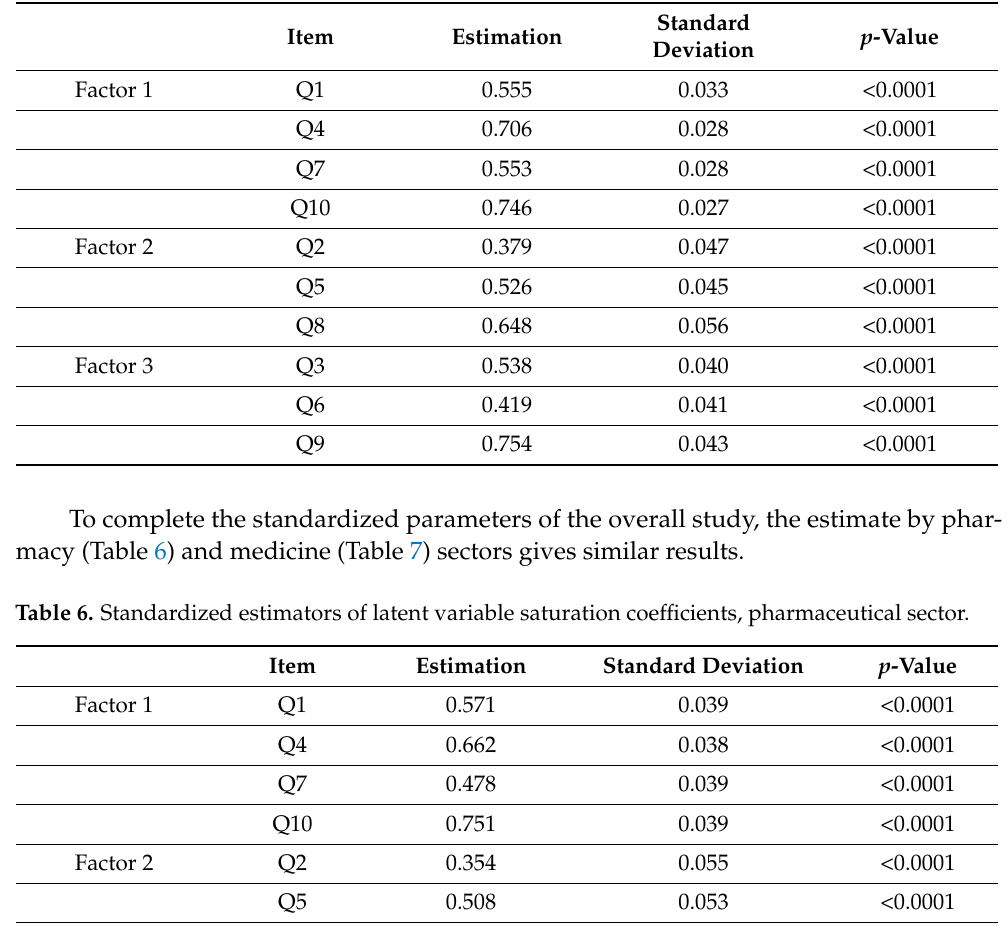
Table 5. Standardized estimators of the loading coefficients of the latent variables.